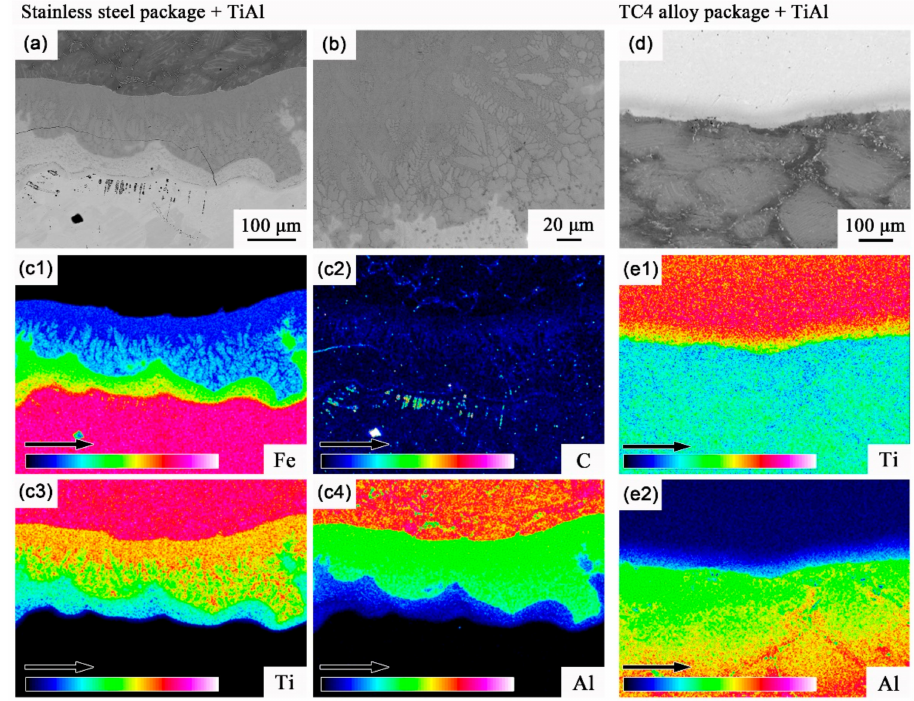
Figure 4. Morphology and solute distribution at the contact interface between the packaging layer and the Ti-46Al-8Nb matrix: ( a ) microstructure, ( b ) reaction interface, and ( c1 – c4 ) solute distribution for the stainless steel package; ( d ) microstructure and ( e1 , e2 ) solute distribution for the TC4 alloy